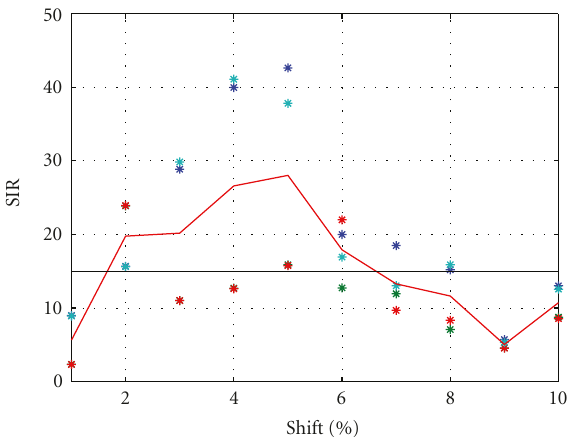
Figure 4: Average and bit by bit signal to interference ratio for the received signal with 4 simultaneous bits ( m = 4) with di ff erent shift steps (in percentage of the transmitted signal length ( T sig